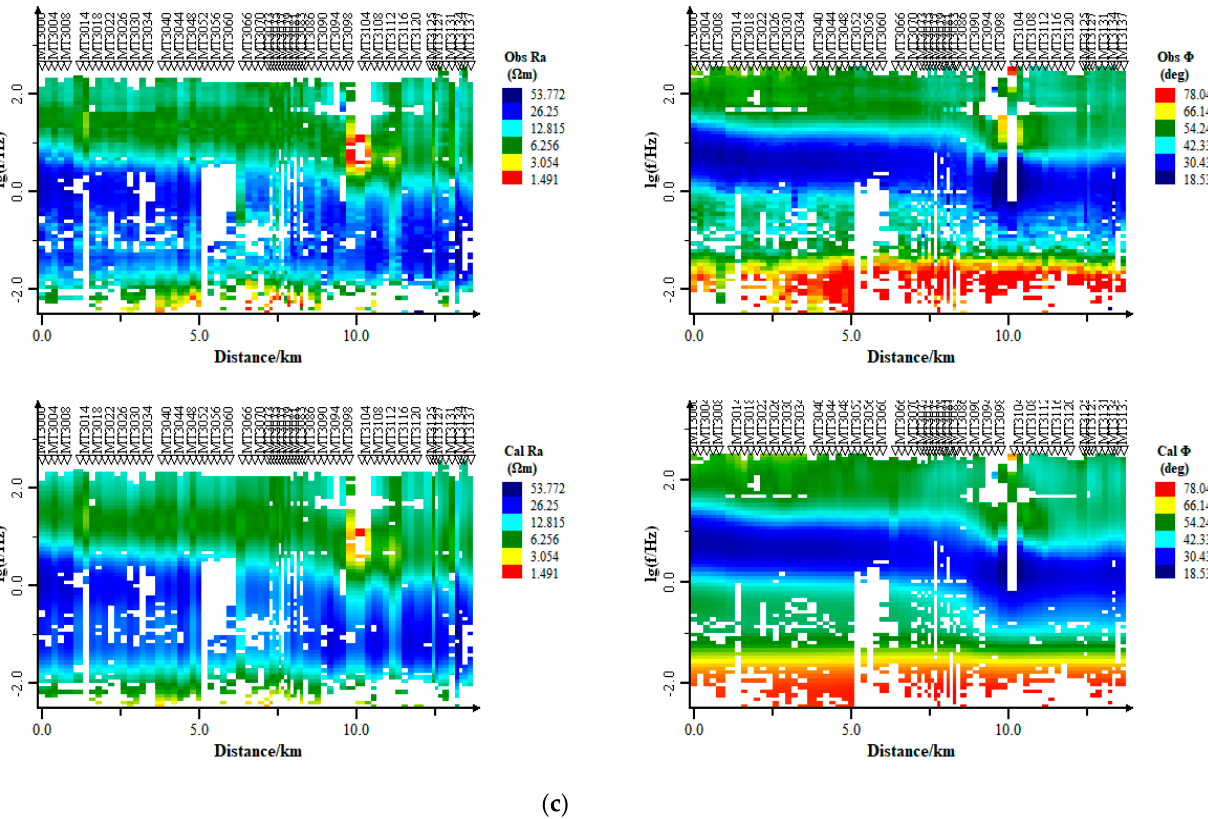
Figure 10. Pseudo cross-section of the observed data and inverse model response for profiles L1–3. (Left is apparent resistivity, right is impedance phase, top is observed data, and bottom is inverse model response. The blank region in the pseudo sections represents the deleted data.) ( a ) L1 profile, ( b ) L2 profile, and ( c ) L3 profile.